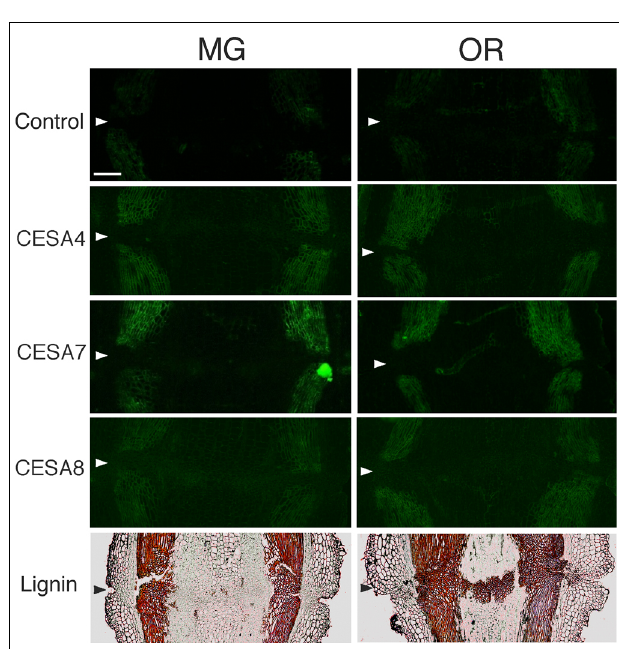
FIGURE 7 | Immunolocalization of CesA4, CesA7 and CesA8 epitopes in the AZs of mature green (MG) and over-ripe (OR) fruit pedicels. Longitudinal sections of MG fruit pedicels, including the AZ, were stained with the anti-CesA4, 7, and 8 antibodies. Micrographs show the negative control without the first antibody step. Phloroglucinol staining for lignin of AZs in MG and OR fruit pedicels. Arrowheads indicate the AZs. Bar = 0.5 mm.